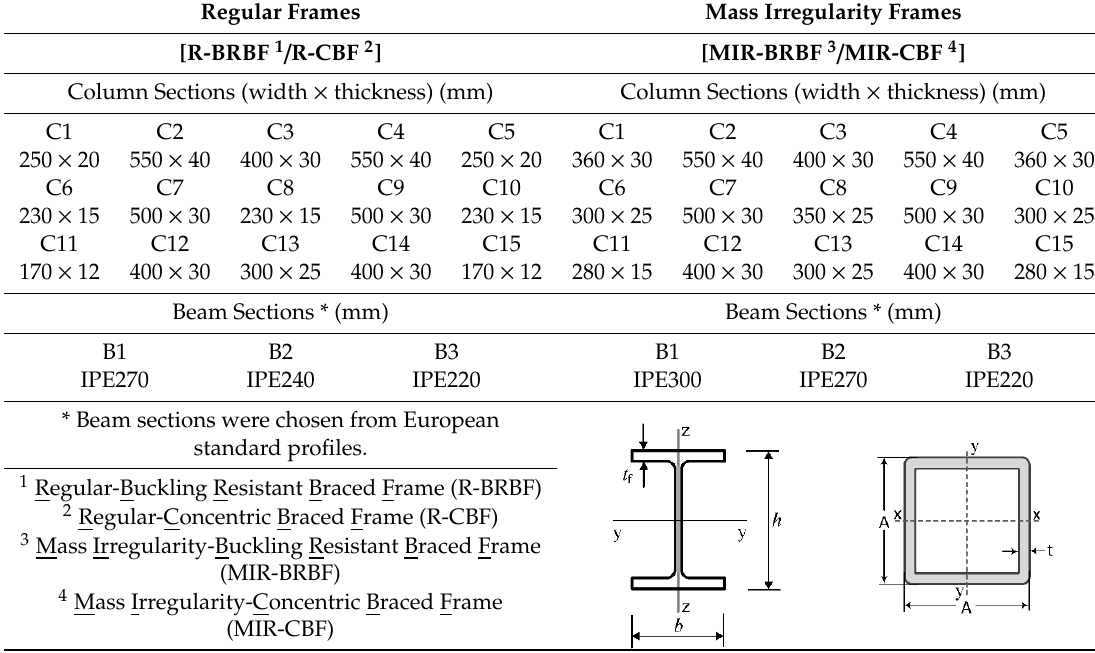
Table 1. Columns and beams cross sections—10-Story frames.